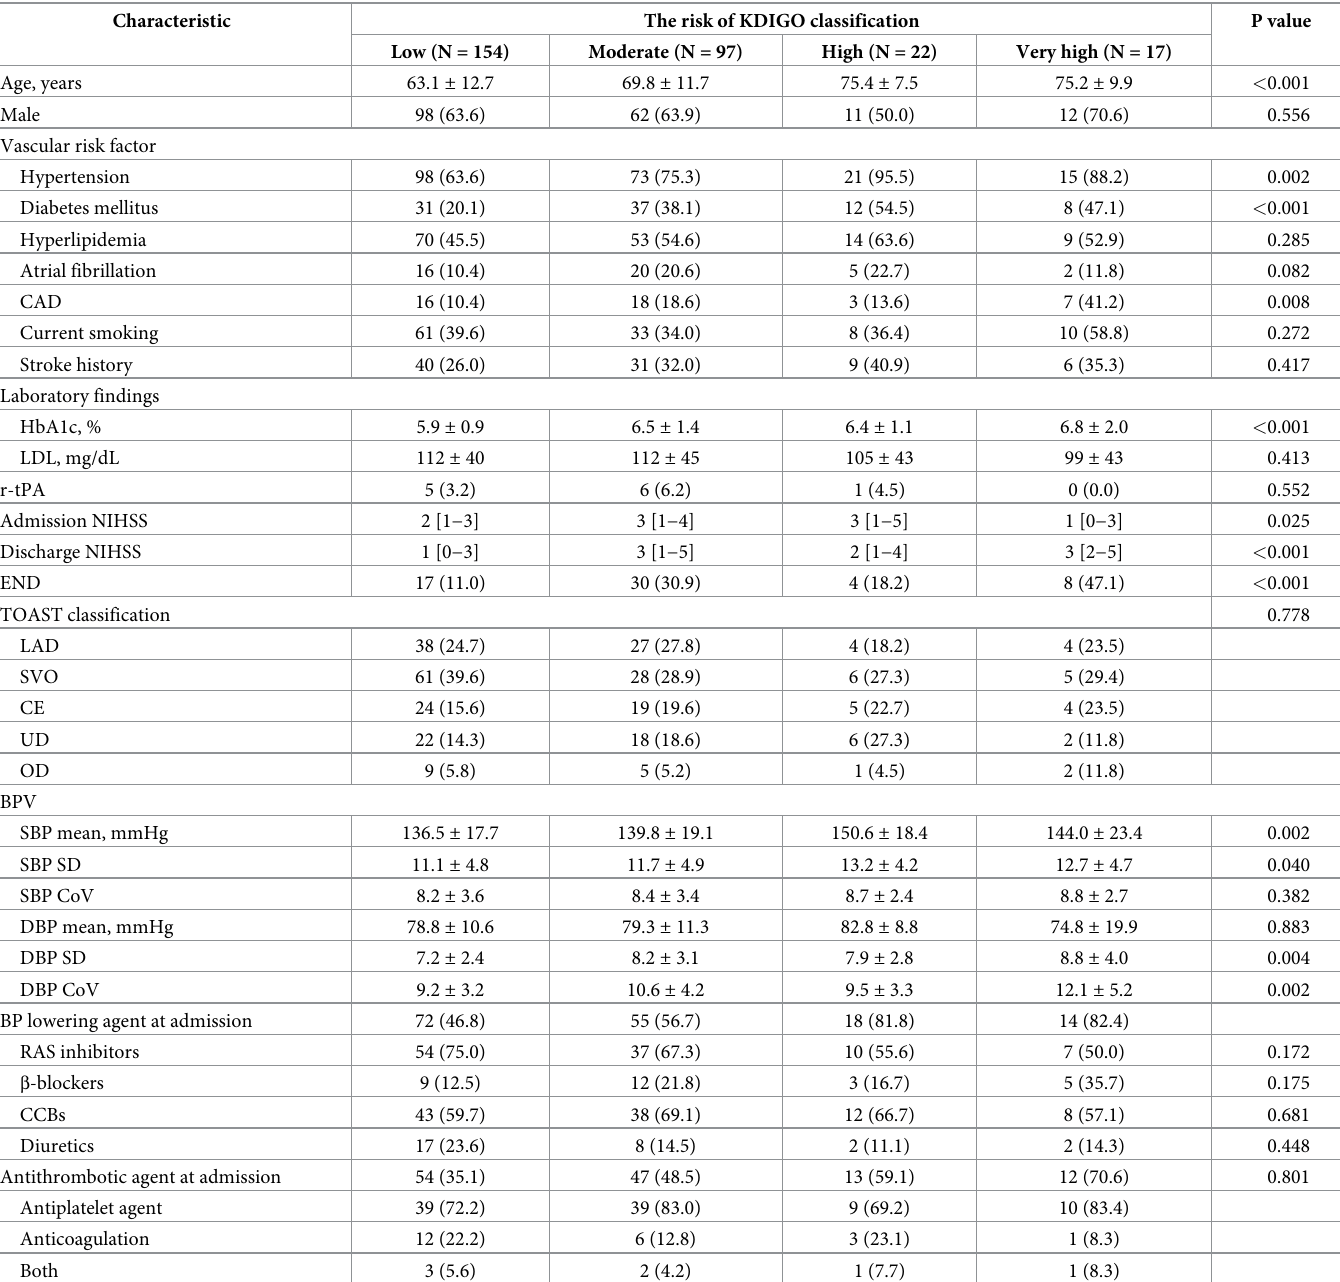
Table 1. Comparison of patient clinical characteristics and BPV according to the risk of KDIGO